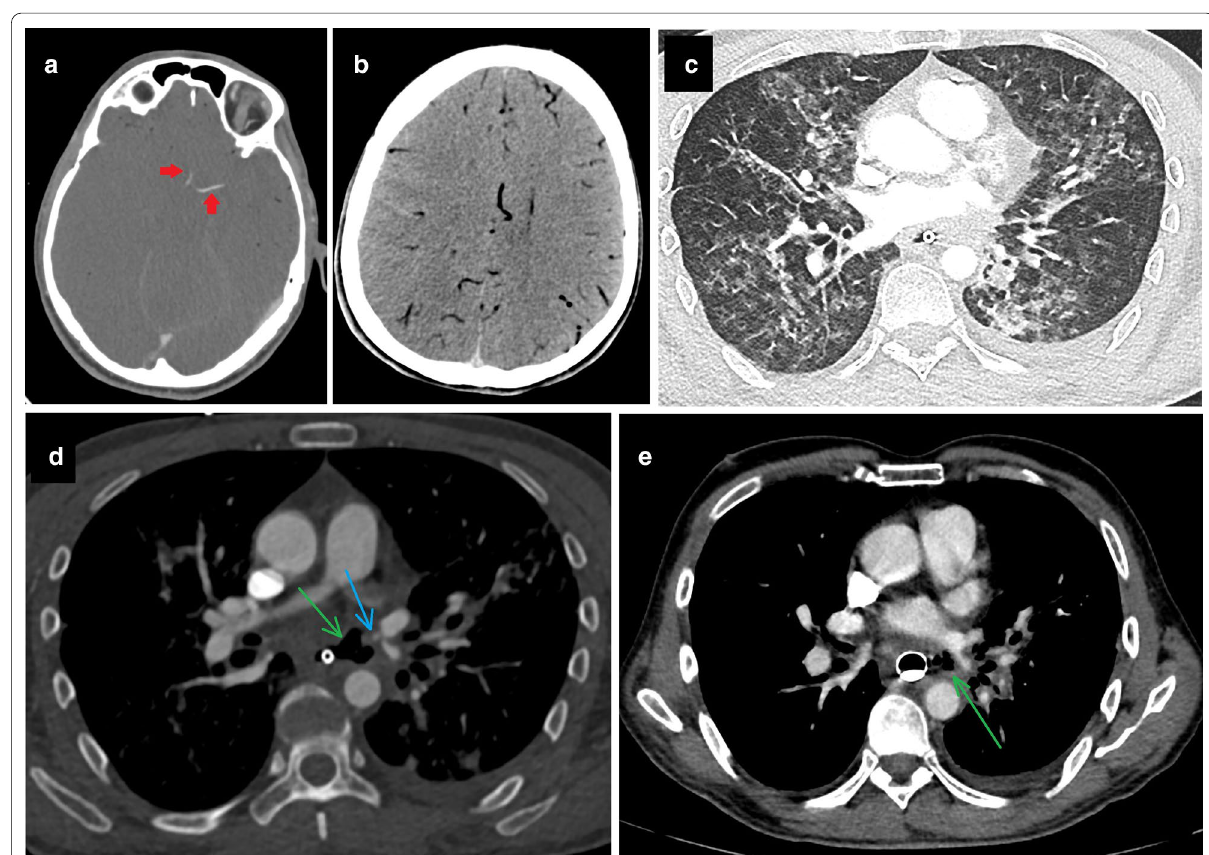
Fig. 19 Zebra retreat and hindsight bias. A 75-year-old male patient with known tracheoesophageal fistula (green arrows, d , e ) suddenly lost consciousness. Brain CT and CT angiography revealed edematous brain tissue, diffuse air within brain vasculature ( b ), and contrast filling limited to just proximal segments of the left middle cerebral artery and anterior cerebral artery (red arrows, a ). Recent studies of the patient were re-evaluated to detect the etiology of cerebral air embolism. On thorax CT taken 3 days previously for hemoptysis, there was seen to be parenchymal ground glass opacities suggesting hemorrhage ( c ). In the mediastinal window, next to the fistula, there was an outpouching of the pulmonary vein (blue arrow, d ) that had not been present on the previous study ( e ). The on-call radiologist had also noticed this newly developed outpouching but did not feel confident enough to mention this finding in the report due to the absence of apparent contrast extravasation into the tracheal lumen. Moreover, the radiologist had thought that hemoptysis originating from a pulmonary vein was quite an unexpected situation. This phenomenon is called a “zebra retreat.” It seems to be impossible to overlook or underrate that outpouching with “a priori knowledge of diffuse cerebral